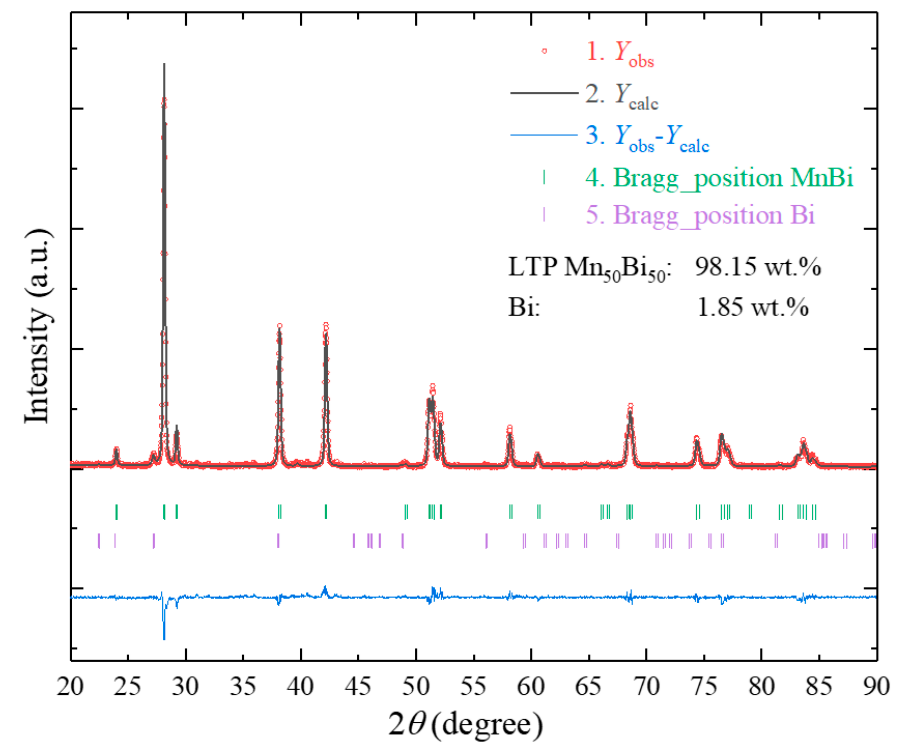
Figure 4. Refined XRD pattern of the annealed Mn 56 Bi 44 bulk samples (320 ◦ C for 5 min). The magnetic hysteresis loops of the Mn 56 Bi 44 − x Mg x (0 ≤ x ≤ 5) bulk samples obtained after magnetic annealing under 2.5 T are shown in Figure 5. The hysteresis loops were smooth and did not contain any kinks until x = 3; however, a kink appeared at x = 4. As the Mg content increased, the magnetization at the maximum magnetic field and remanent magnetization decreased, whereas H c increased to 9659 Oe for x = 4 and then decreased at higher values of x . The magnetization, squareness, H c , and ( BH ) max of the Mn 56 Bi 44 − x Mg x (0 ≤ x ≤ 5) bulk samples are plotted in Figure 6. Although the magnetization at the maximum field and remanent magnetization decreased as x increased, ( BH ) max increased slightly from 5.62 MGOe (for Mn 56 Bi 44 ) to 5.64 MGOe (for Mn 56 Bi 43 Mg 1 and Mn 56 Bi 42 Mg 2 ) because of the increased squareness ( M r / M s ≈ 0.8). At x values exceeding 2, ( BH ) max decreased linearly. The decreasing magnetization and increasing H c for x ≥ 2 originate from phase decomposition into nonmagnetic phases. The XRD patterns for the field-annealed samples will be published elsewhere. These impurities act as pinning centers for domain walls by strongly inhibiting their motion, thus reducing the e ffi ciency of this reversal